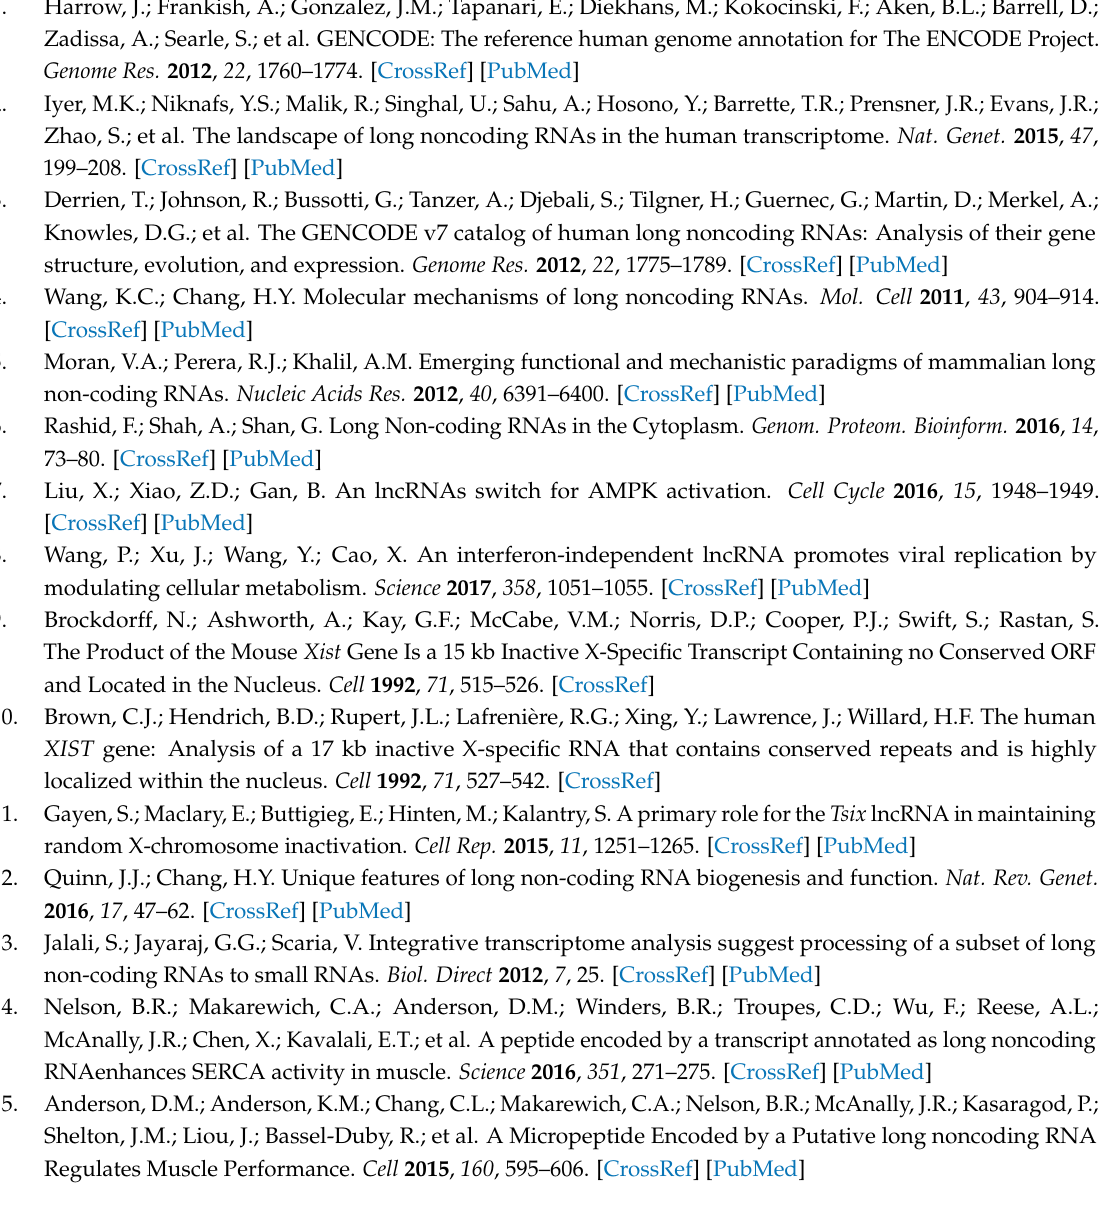
Table S1: lncRNAs described in the homeostasis of different cells and